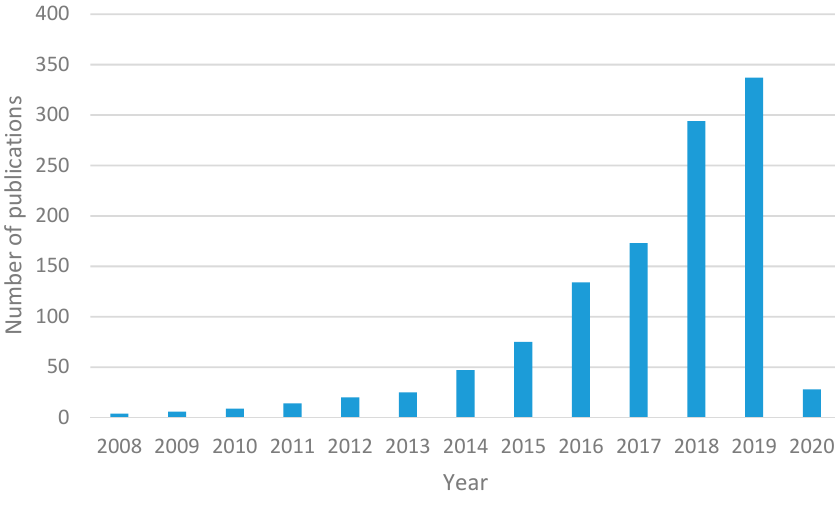
Figure 3. Number of articles on ‘prosumer flexibility’.